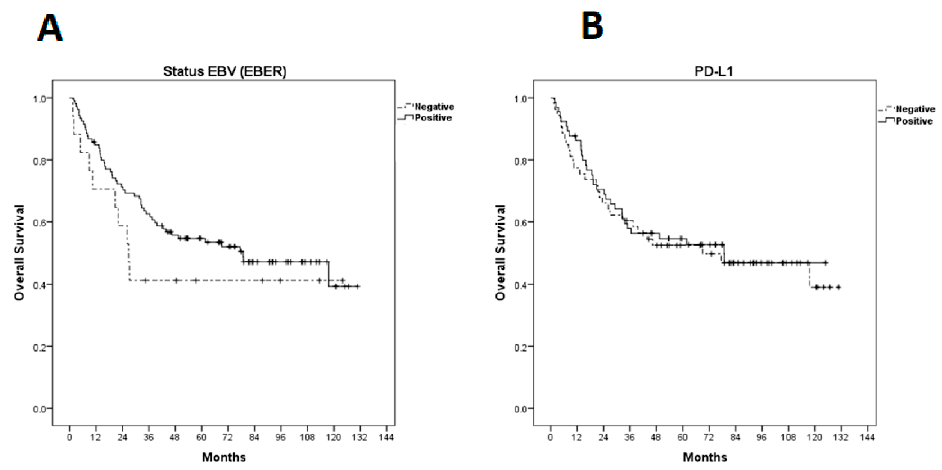
Figure 4. Kaplan–Meier curves for overall survival (OS). ( A ) OS according to EBER (Epstein–Barr- virus-encoded small RNAs); ( B ) OS according to programmed cell death ligand-1 expression. Additionally, there was no significant difference regarding OS when comparing patients with high PD-L1 expression (TPS ≥ 50%) versus low expression (TPS < 50%) or negative TPS ( p = 0.750) or when compared in relation to high CPS expression ( ≥ 20) versus low CPS expression (<20) or negative CPS ( p = 0.846).